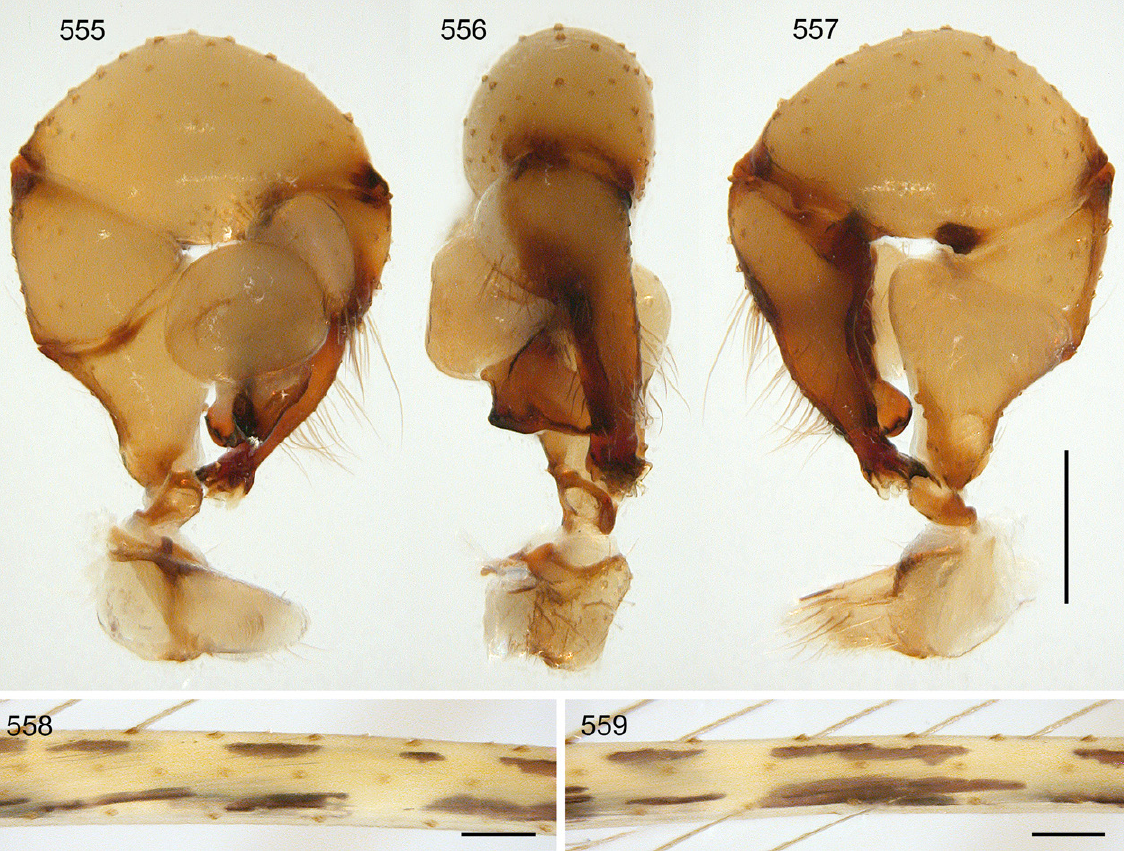
Figs 555–559. Crossopriza khayyami sp. nov., non-type male and female from Iran, Fars, Izad Khast (MHNG). 555–557 . Left male palp, prolateral, dorsal, and retrolateral views. 558–559 . Female femora 1 and 2, retrolateral views. Scale bars: 555–557 = 0.5 mm; 558–559 = 0.2